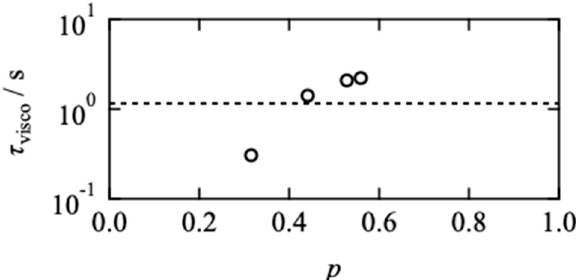
Figure 2. Viscoelastic relaxation time ( τ visco ) as a function of p . Dashed line represents the dissociation time of end groups estimated by surface plasmon resonance in our previous report [29,30].